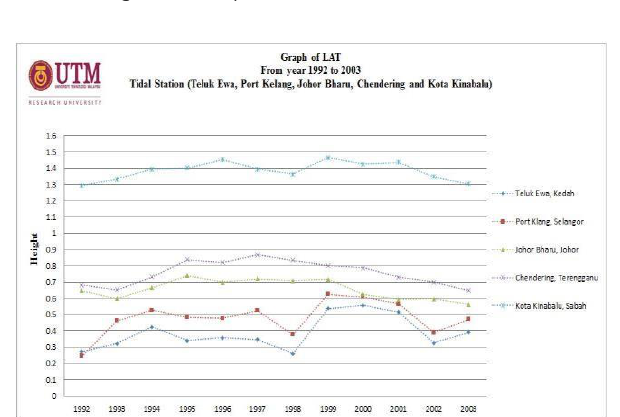
Figure 10. Graph of Tidal Constituent of Mm